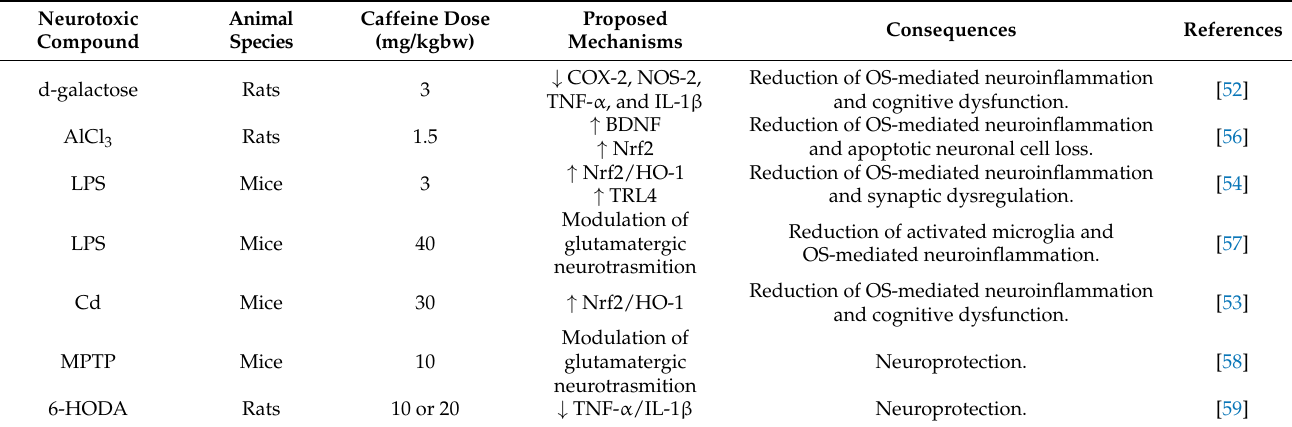
Table 1. The proposed neuroprotective mechanisms of caffeine after in-vivo animal exposure to neurotoxic